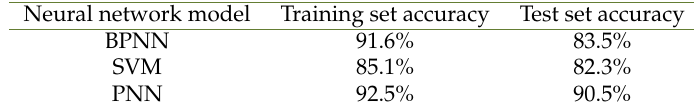
Table 1. Comparative Analysis of fault classification and diagnosis models Neural network model